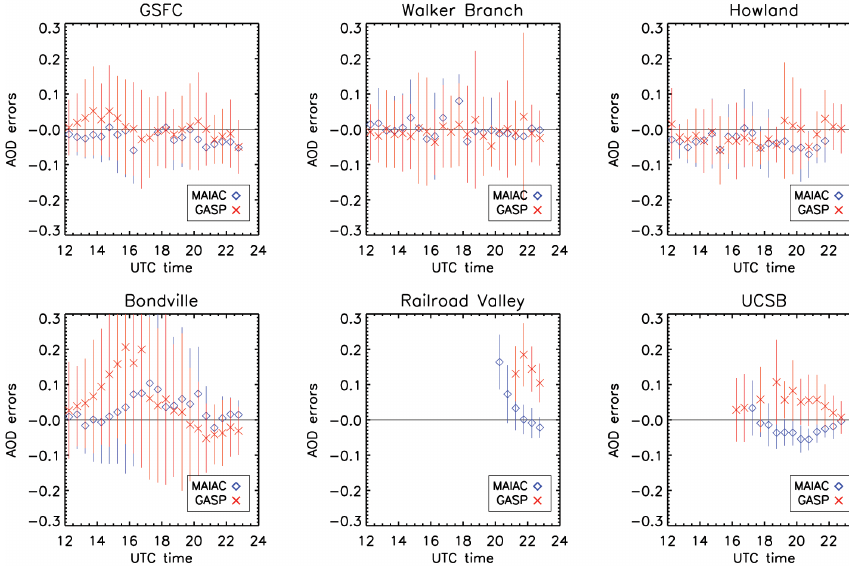
Fig. 7. AOD retrieval errors vs. UTC time. AOD retrieval error is defined as GOES AOD minus AERONET